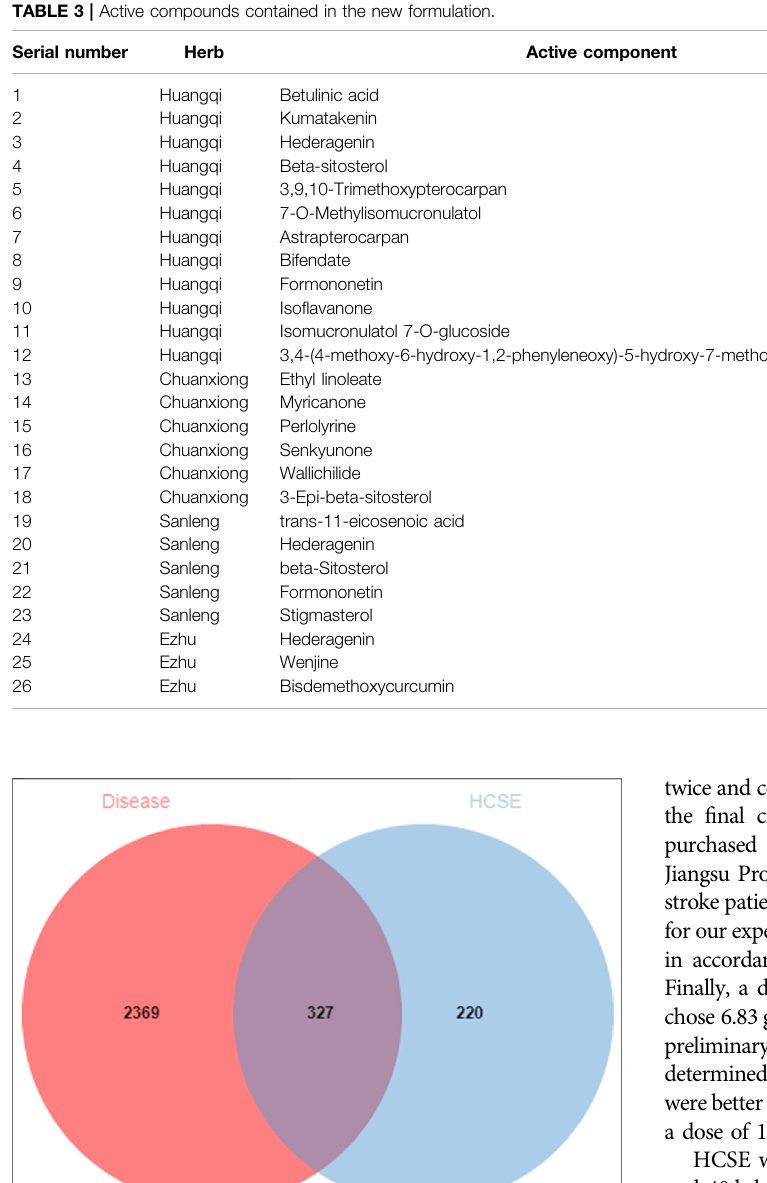
Frontiers in Pharmacology |